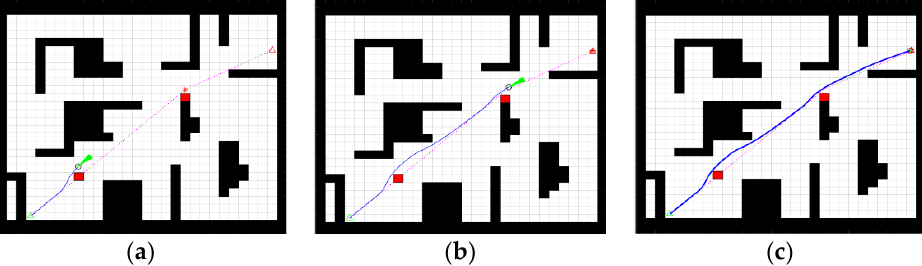
Figure 15. Overall trajectory. ( a ) First avoidance, ( b ) Second avoidance, ( c ) Reaching the target.